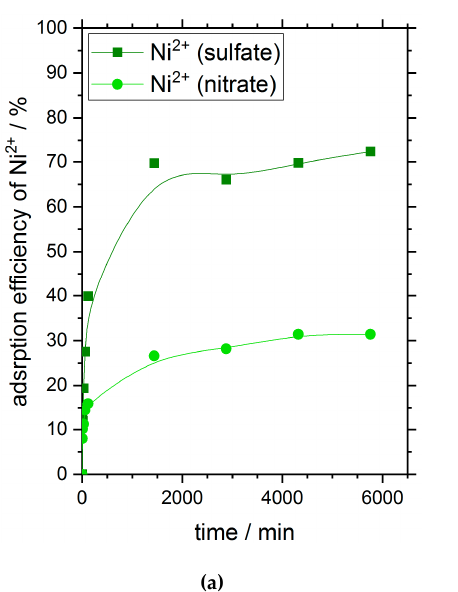
Figure 1. Adsorption efficiency of nickel ions in dependence on time and their associated anions at 25 °C. ( a ) displays the full period of time (6000 min) and indicates the adsorption equilibrium in dependence of time; ( b ) shows the first 200 min of the measurement displayed in ( a ) and gives evidence of a two-stage adsorption process. Initial nickel concentration and initial pH-values of the sulfate and nitrate solution were 180 mg·L − 1 and 6.1 ± 0.05, respectively.